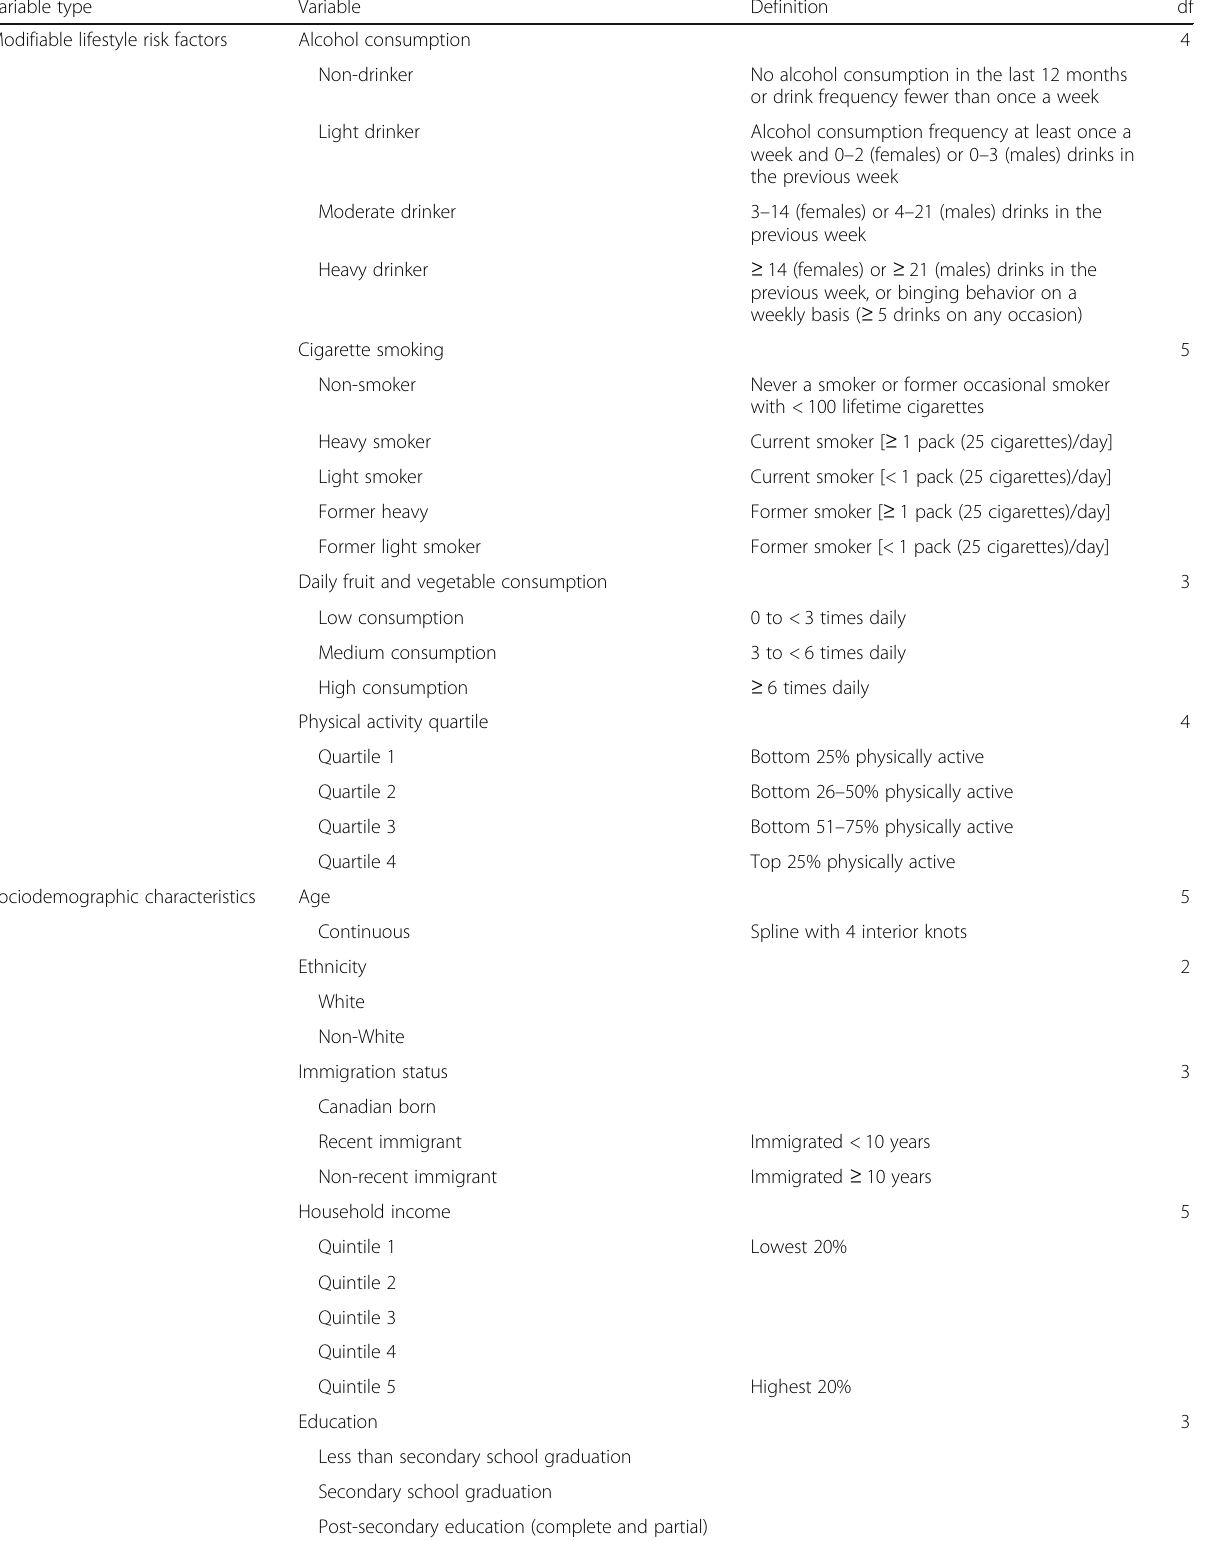
Table 2 Pre-specified definitions of CDPoRT predictors Variable